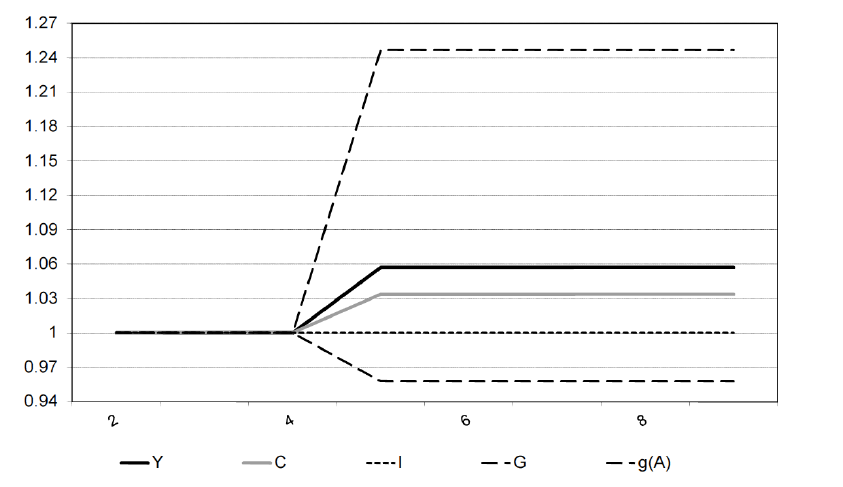
Figure 5. Increase in public spending (with the budget deficit) coupled with an increase in the carbon tax (Case 5) Table 1. Comparing results of the AS-AD model and the ‘Pure Keynesian’ model AS-AD Model by Fagnard Variable